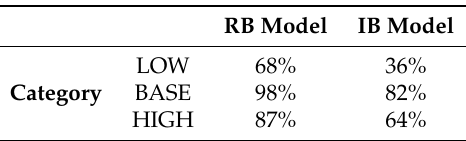
Figure 3. Illustration of Nash equilibrium for the scheduling game at day 5 in week 38. Each row represents a schedule (i.e., a set of options—one for each interval; cf. (7)), chosen by the respective player. On the left, the results under consideration of a realistic battery model are shown, whereas on the right an ideal battery model is applied. Table 3. Comparison of participation rates depending on the battery model and consumption category. Results are obtained by averaging over all weeks.